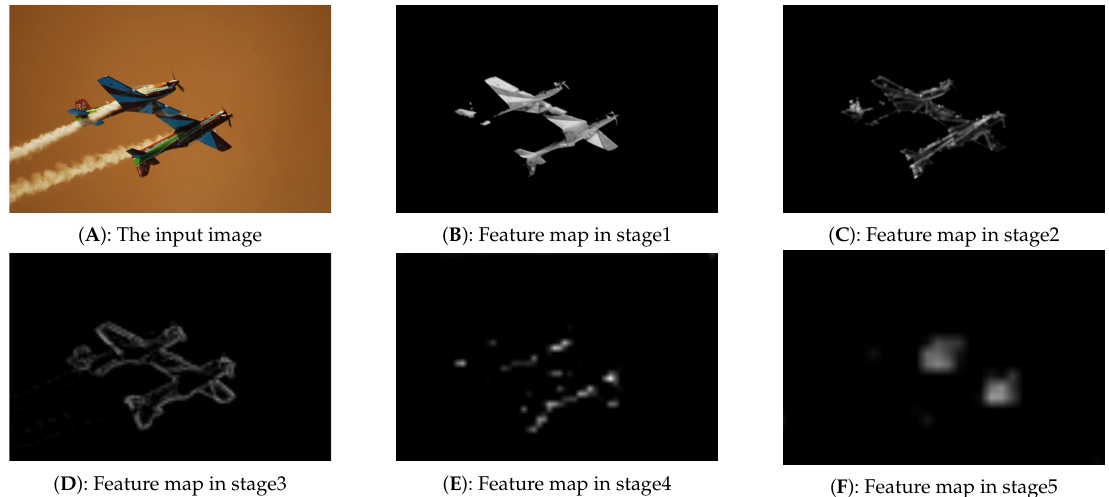
Figure 1. The multi-scale feature maps generated by ResNet50 [38]. ( A ) is the original input image with a size of 1024 × 1024 × 3. The ( B – F ) respectively come from the five different stages of the multi-scale convolutional neural network (CNN) feature maps and their panel size are 512 × 512, 256 × 256, 128 × 128, 64 × 64, 32 × 32. In this figure, all of them has been resized to the same size for convenient